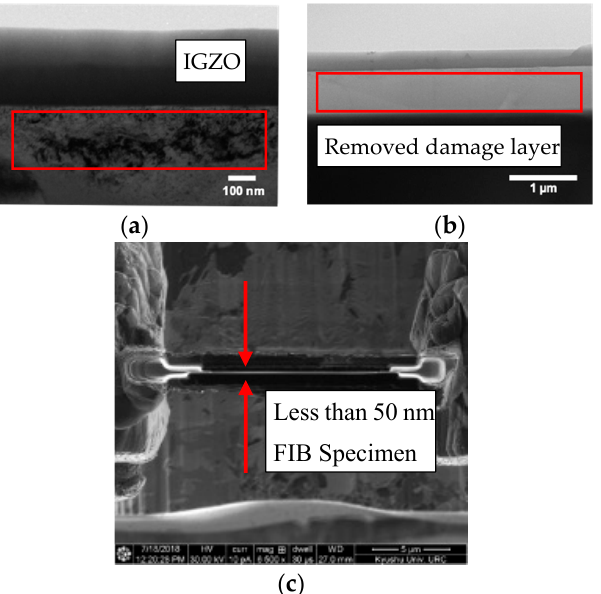
Figure 2. ( a ) Bright-field (BF) transmission electron microscopy (TEM) image of a cross-sectional IGZO/ α -Al 2 O 3 film indicating Ga ion beam damage (red box), ( b ) a cross-sectional BF-TEM image after subsequent low-power Ar milling that effectively removed the damaged layer on the cross- sectional specimen (red box), and ( c ) a plan-view secondary-ion microscopy image of the thin foil specimen with a thickness less than 50 nm prepared by the Ga/Ar ion beam-milled Sample B.